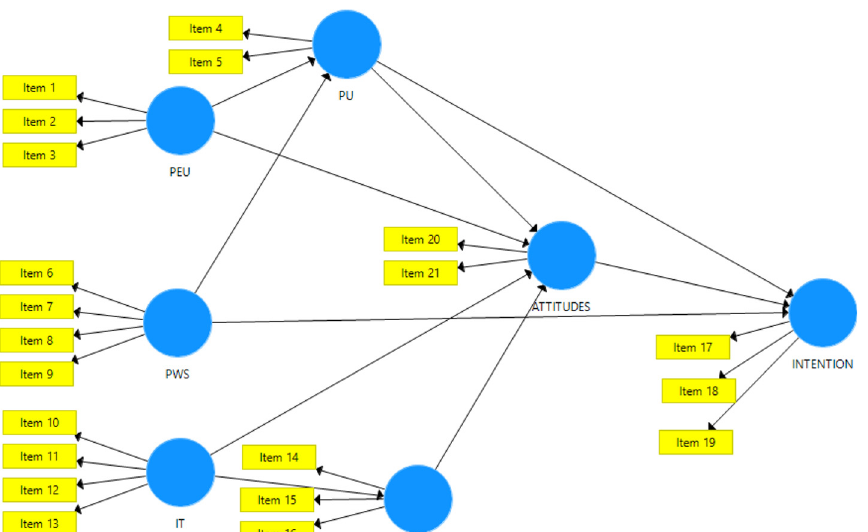
Figure 2. Path diagram